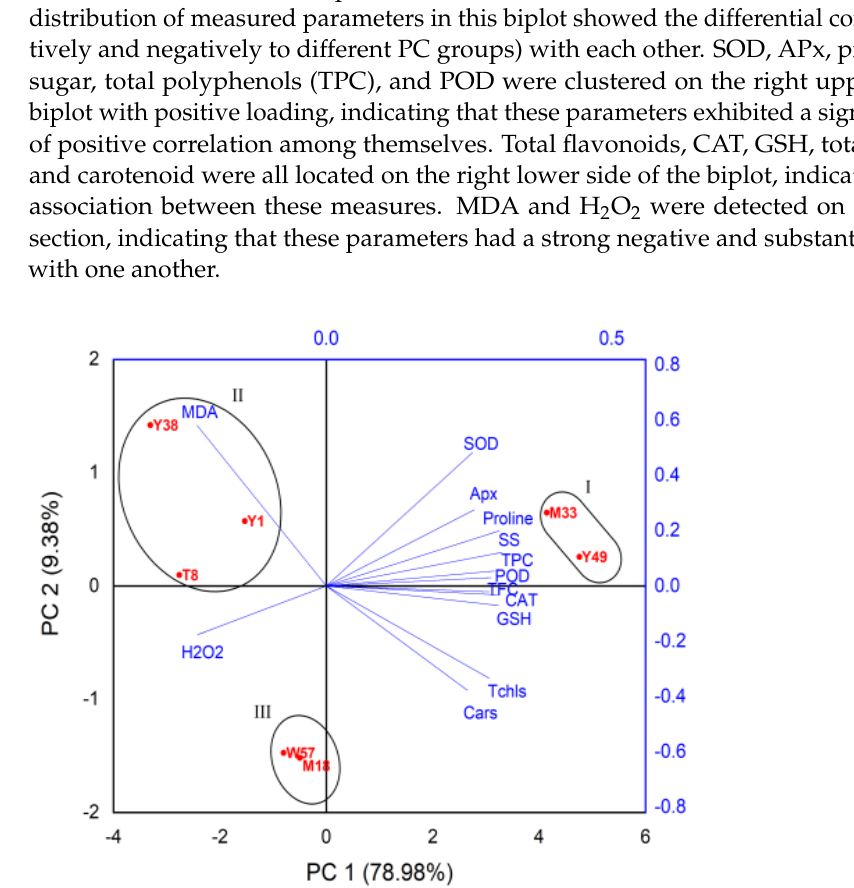
C. olitorius (Figure 5). Cumulative PCA biplot contributes 88.36% of the total variability of the studied parameters, while PC1 accounts for 78.98% and PC2 accounts for 9.38% of the